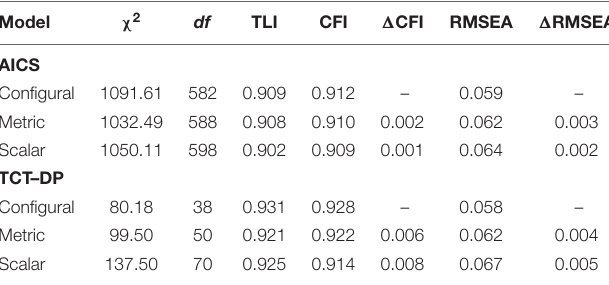
TABLE 4 | Analysis of the measure invariance across the rice and the wheat culture.